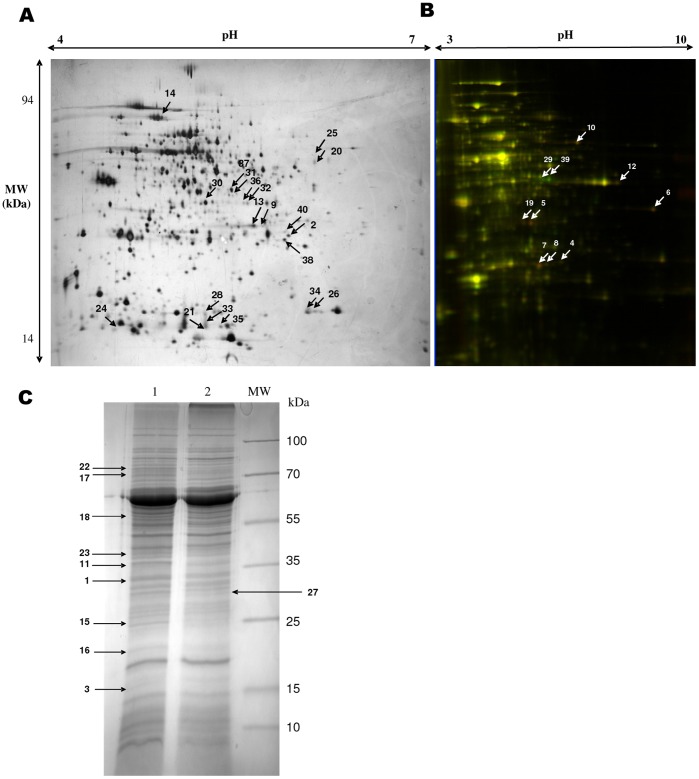
Differential proteome analyses depending on hydrostatic pressure.Proteome profiles of D. piezophilus. A. Overview of the proteome profile obtained by 2DE-gels of soluble proteins recovered from D. piezophilus grown at 10 MPa. The proteins (100 µg) were separated by 2D gel electrophoresis on a pH gradient of 4–7 and a 10–18% polyacrylamide denaturing gradient, and the gel was silver-stained. A total of 727 protein spots were detected. B. Overlapping DiGE images of the D. piezophilus proteome. The proteins were separated on a pH gradient of 3–10 and a 12% polyacrylamide denaturing gel (Cy3-green  = 10 MPa; Cy5-red  = 0.1 Mpa). A total of 940 protein spots were detected. C. Sodium dodecyl sulfate-polyacrylamide gel electrophoresis of the membrane protein fraction of D. piezophilus recovered at low (0.1 MPa, Lane 1) or high (10 MPa, Lane 2) hydrostatic pressure. Molecular weight standard, MW. The arrows indicate the positions of the differentially abundant proteins according to the hydrostatic pressure growth conditions.